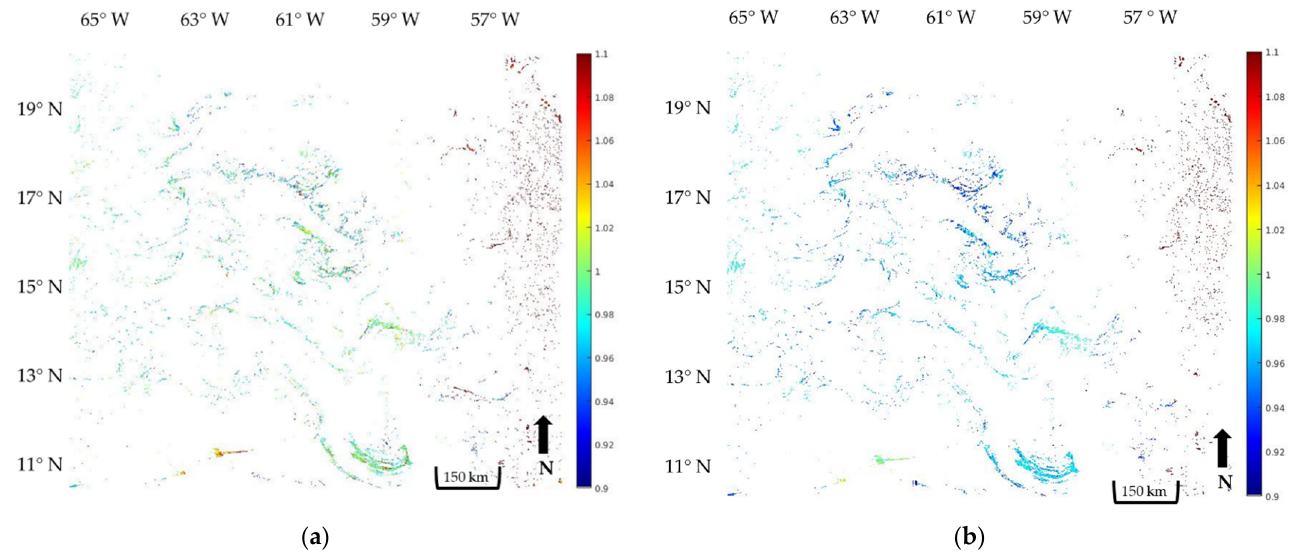
Figure 10. Spectral ratio of the aerosol and sunglint reflectance ρ ag ( 754 ) / ρ ag ( 681 ) over Sargassum- dominated areas in the scene acquired on 8 July 2017 13:00: ( a ) using POLYMER algorithm; ( b ) using POLYMER ext algorithm.